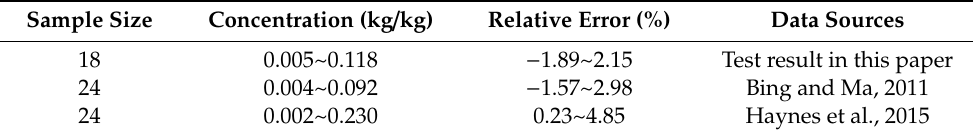
Table 5. Comparison of calculated and measured freezing point (for NaCl).